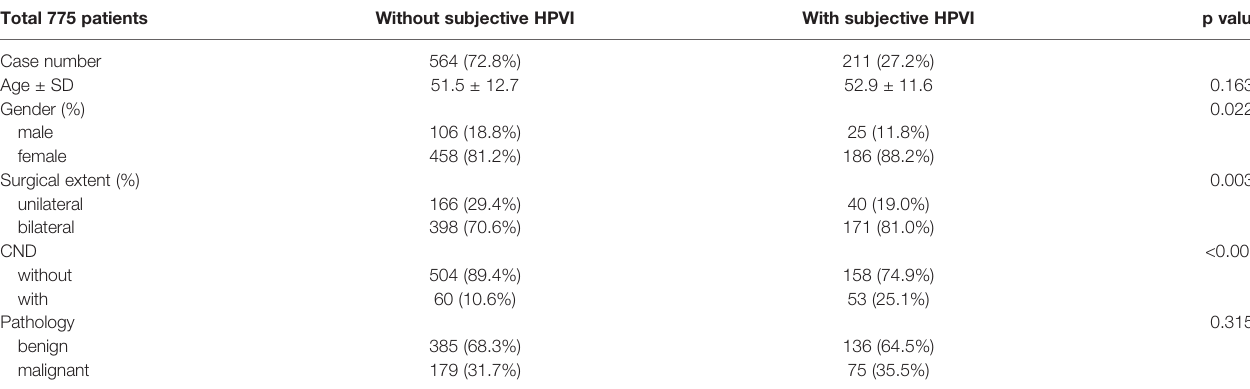
TABLE 3 | Demographic characteristics of patients with and without subjective high-pitched voice impairment